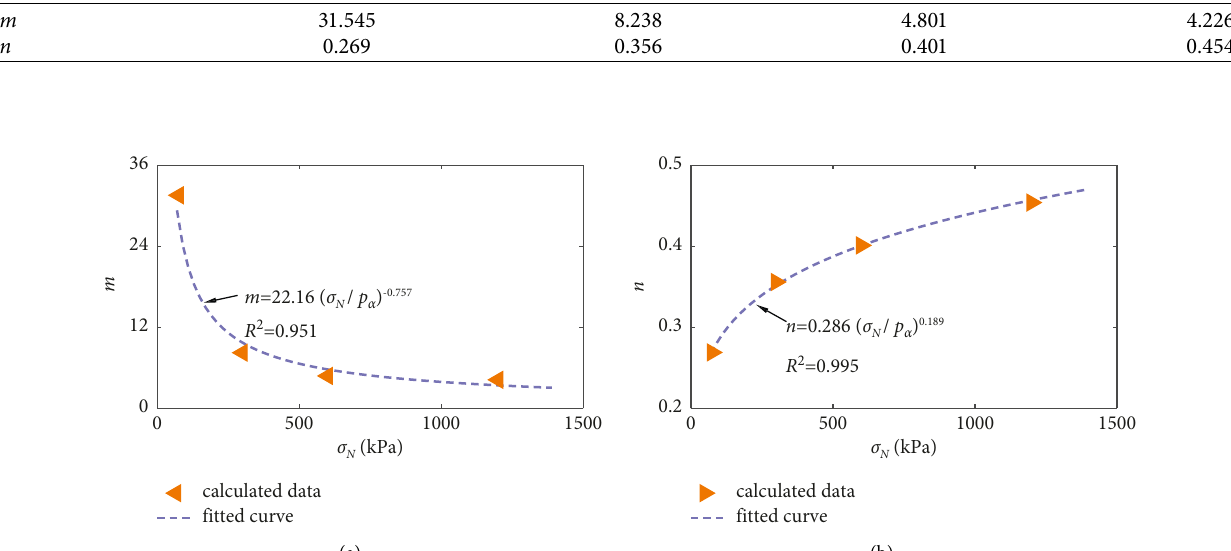
Figure 5: Variations of the Weibull parameters ( m ) and ( n ) with σ determination, respectively).